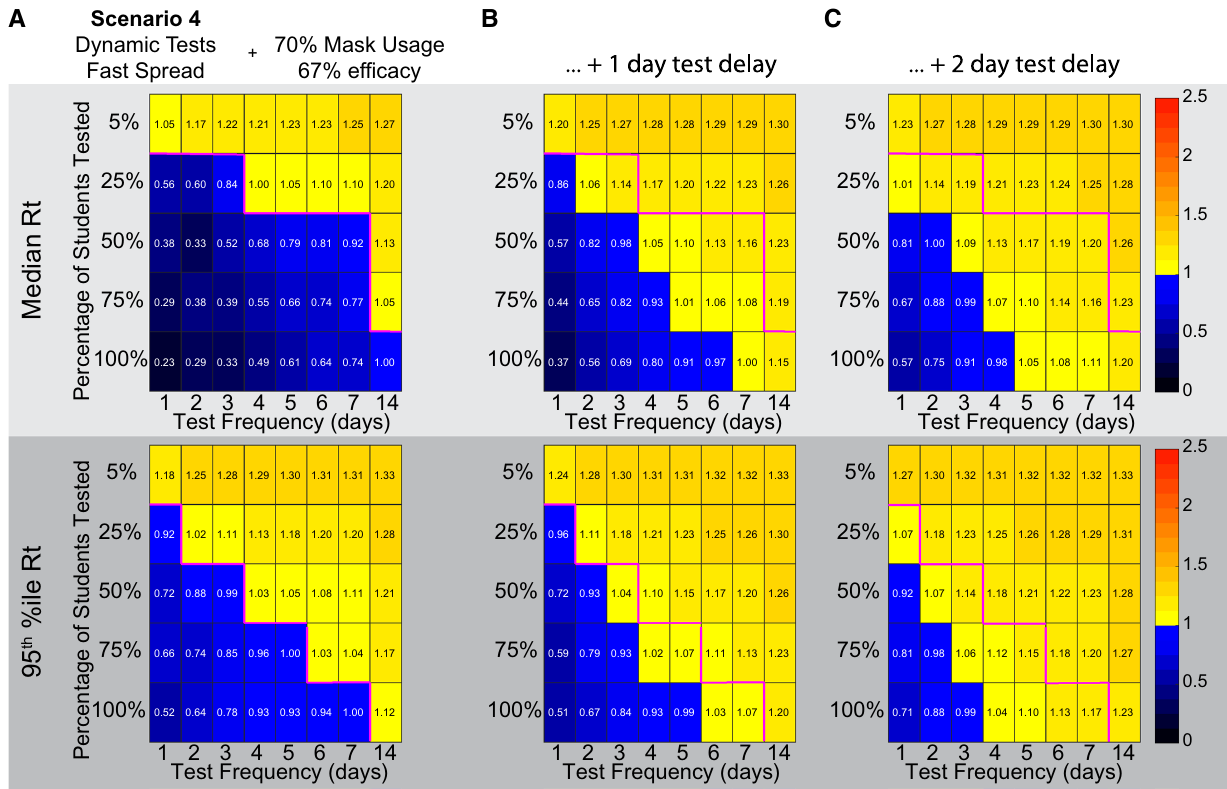
Figure 6. In the presence of masking, fewer tests and lower frequencies of testing can be successful in driving Rt below 1. ( A ) Here we implemented 70% of the population using a mask that is 67% effective with the parameters of Scenario 4, early transmission of virus based on the He et al. viral load data, and dynamic false negative rates for tests based on Kucirka et al. The top row of matrices shows the median effective Reproduction number (Rt), while the bottom row of matrices shows the value of the upper 95th percentile. Masking drove the median Rt from 2.5 to ~ 1.3. Tests were then able to drive the 95th percentile Rt below 1 with less aggressive testing schemes than in Fig. 5. ( B ) The same conditions as ( A ), with an included 1 day turn around delay in testing results. The magenta line shows the border between an Rt above 1 and an Rt below 1 without a delay. ( C ) As in ( B ) with a 2 day turn around delay in testing